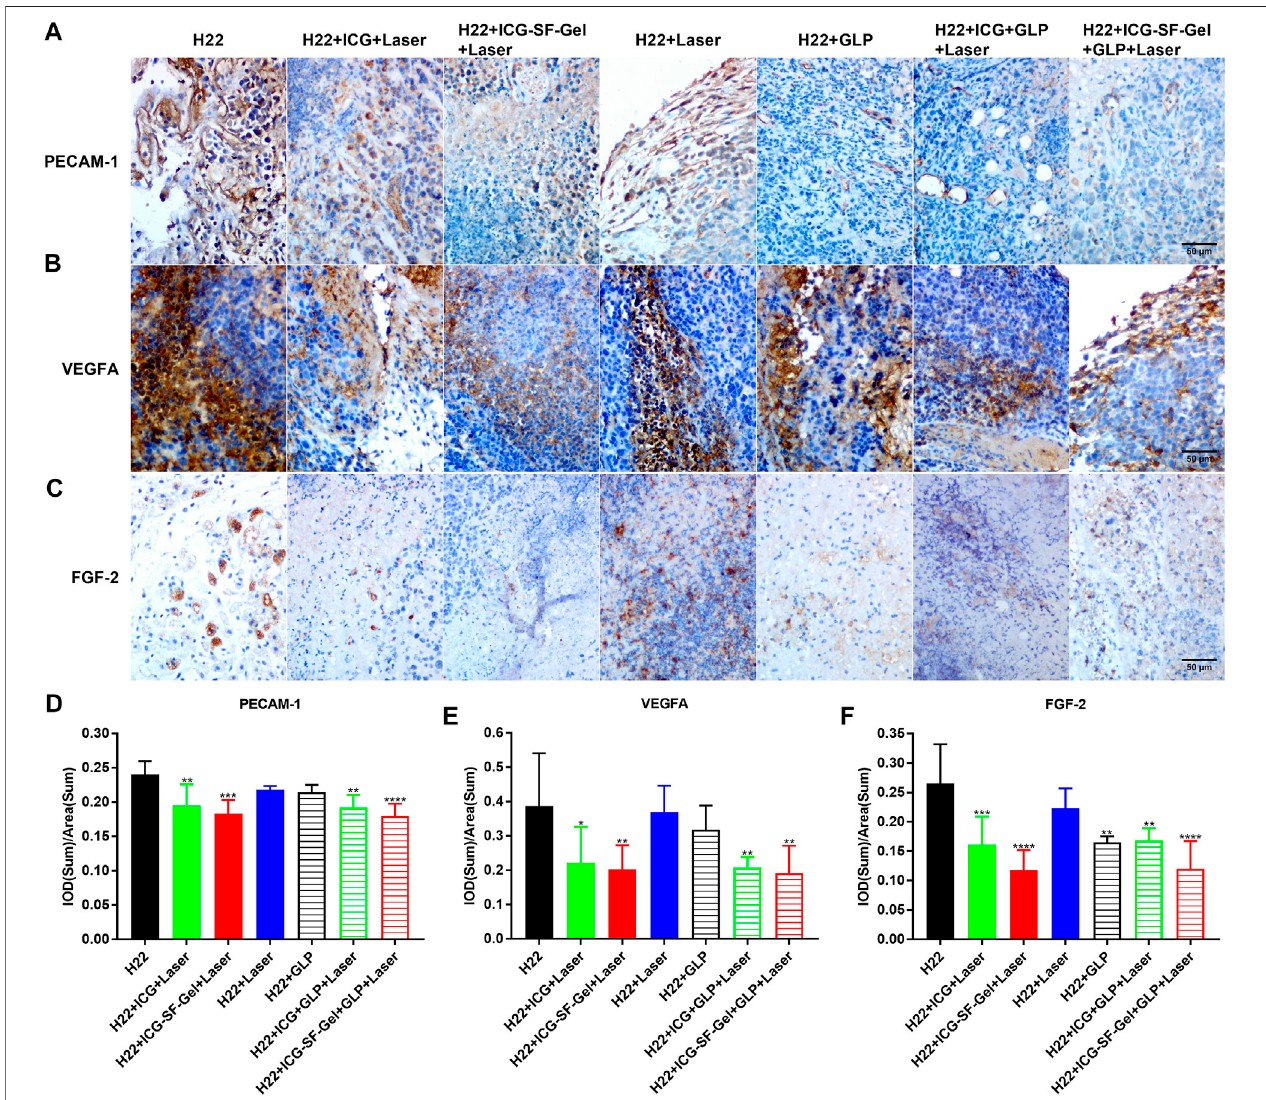
FIGURE 6 | The angiogenesis ofdistal tumors after different treatments. (A – C) Immunohistochemical staining of PECAM-1 (A) , VEGFA (B) and FGF-2 (C) of distal tumors collected from different treated groups of mice 7 days after the distal tumor inoculation (The same row shared the same scale bar: 50 µm) and quantitative analysis of PECAM-1 (D) , VEGFA (E) and FGF-2 (F) ( n (cid:2) 4 mice per group, data are presented as the mean ± SD. Statistical signi fi cance was expressed by * p < 0.05, ** p < 0.01, *** p < 0.001 and **** p < 0.0001, comparing other groups with the H22 group).